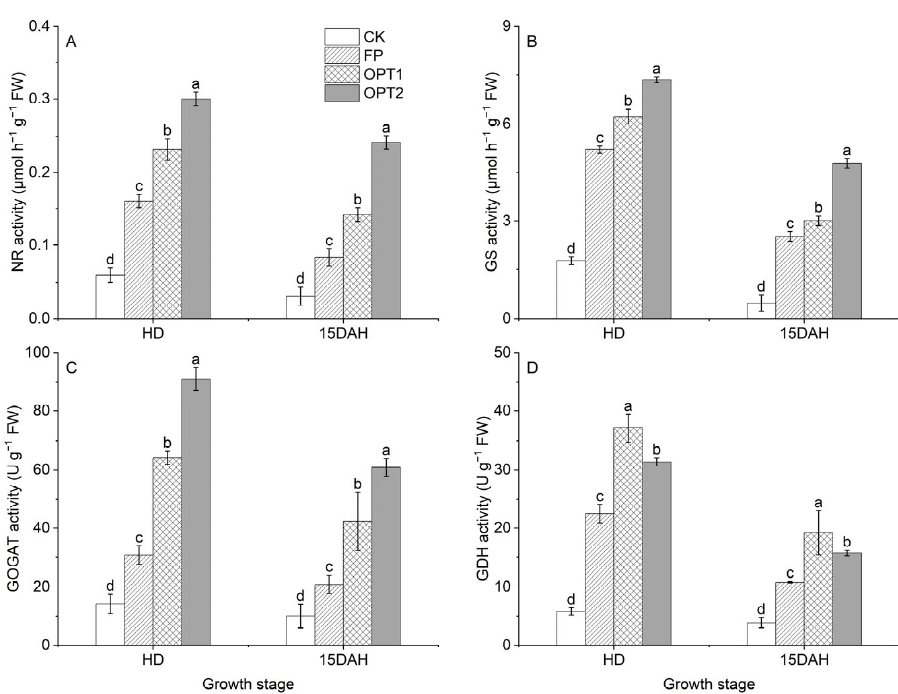
Figure 4. The nitrogen metabolism-related enzyme activity of NR ( A ), GS ( B ), GOGAT ( C ) and GDH ( D ) under four management systems at HD and 15DAH. Means followed by the same letter do not significantly differ (LSD, p < 0.05).